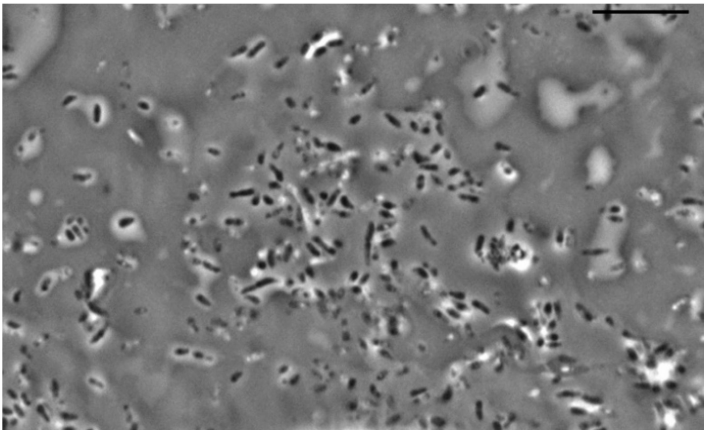
Figure 10. R. qingshengii strain VT6 on hexadecane 4 days of growth. Light microscopy, phase contrast. The length of the scale mark is 10 µ m.